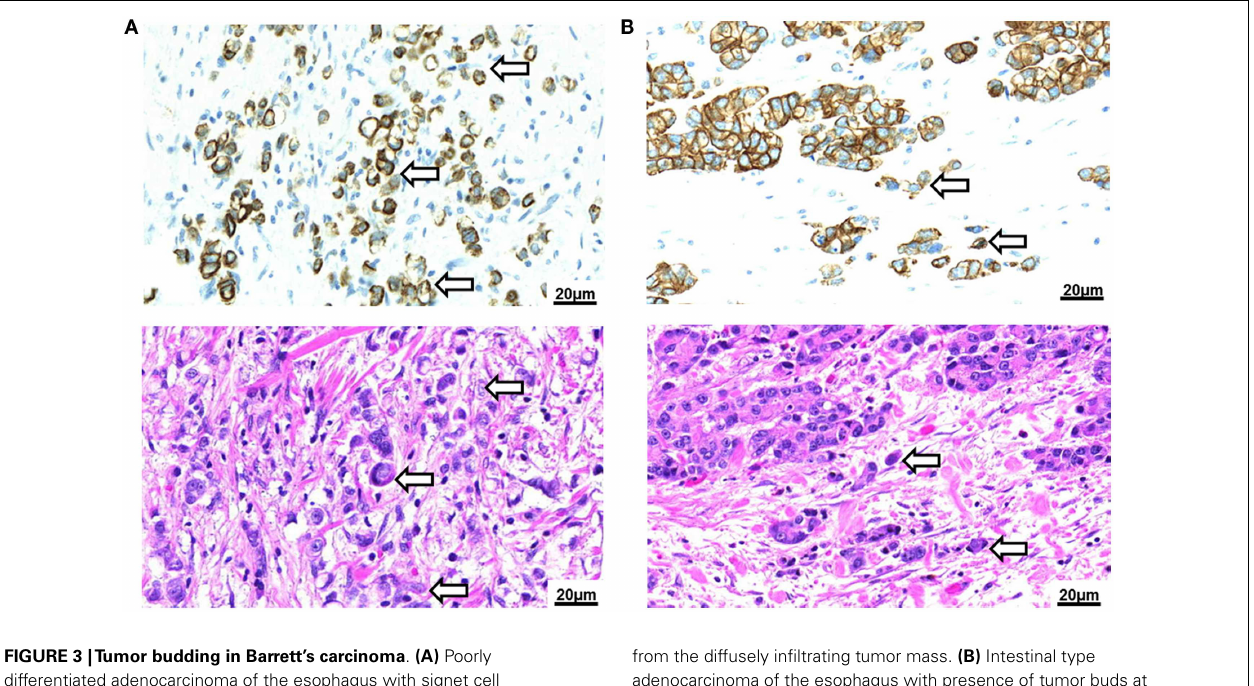
FIGURE 3 |Tumor budding in Barrett’s carcinoma . (A) Poorly differentiated adenocarcinoma of the esophagus with signet cell component as seen in a pancytokeratin (top) and H&E (bottom) stain (250 × ).Tumor buds cannot be differentiated by morphology